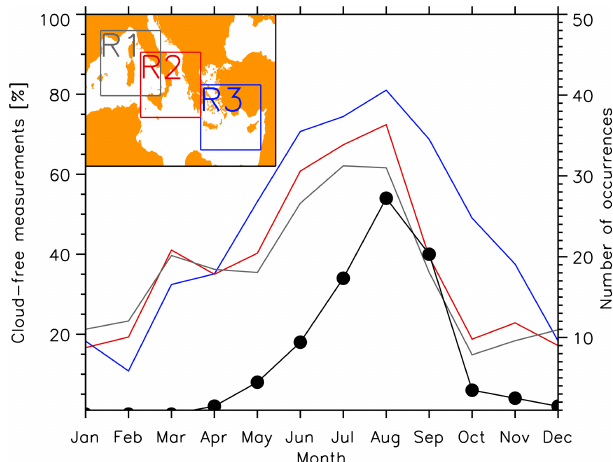
Figure 1. Monthly means of the percentage of cloud-free measure- ments for the three corresponding areas (shown on the top-left map: R1 is grey, R2 is red and R3 is blue) for the year of 2003. The total number of lee wave occurrences (ATSR-2 + AATSR for the whole missions) is also reported as a function of the month (black curve, with the scale on the right-hand